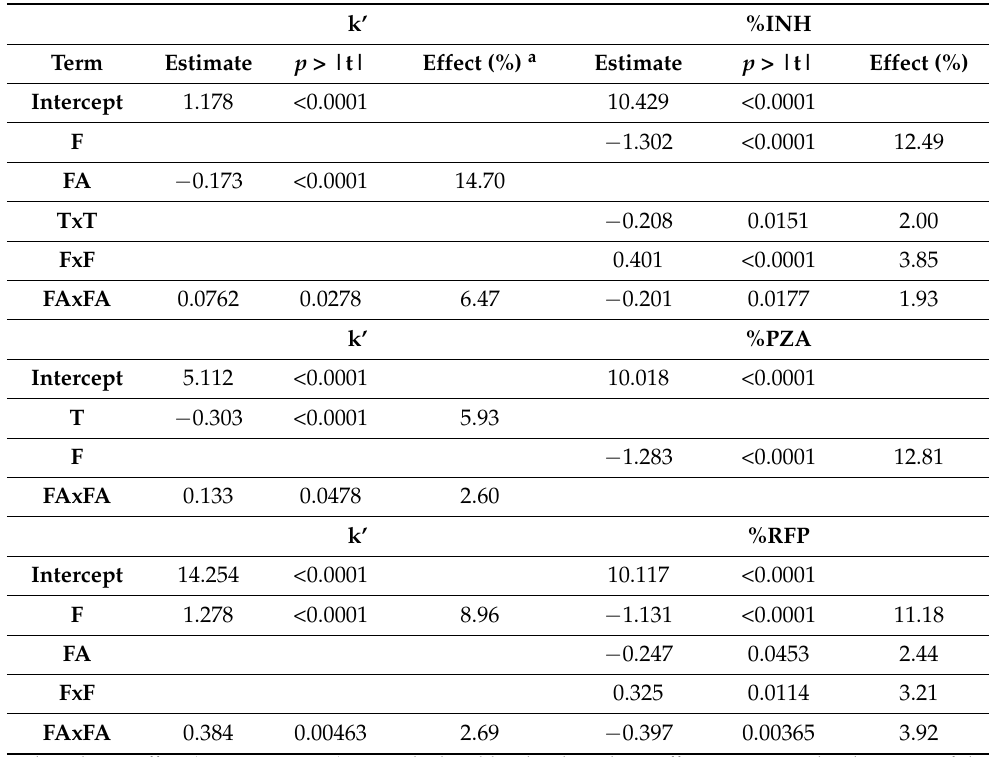
Table 2. Evaluation of the influential factors and their effects on the responses, retention factor (k’), and percentage (%API) for each one analyzed, assuming a second-degree model. Only significant coefficients are given.